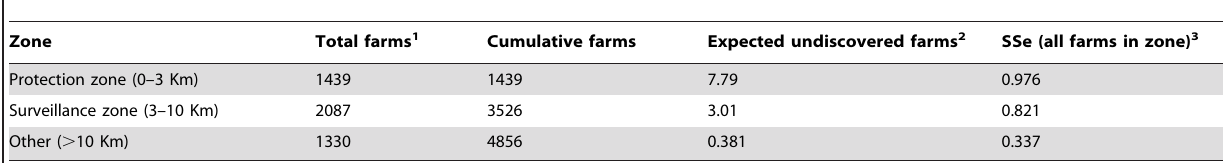
Table 2. The mean result of 500 simulations for the 3 km protection zone, the 10 km surveillance zone and the whole region.